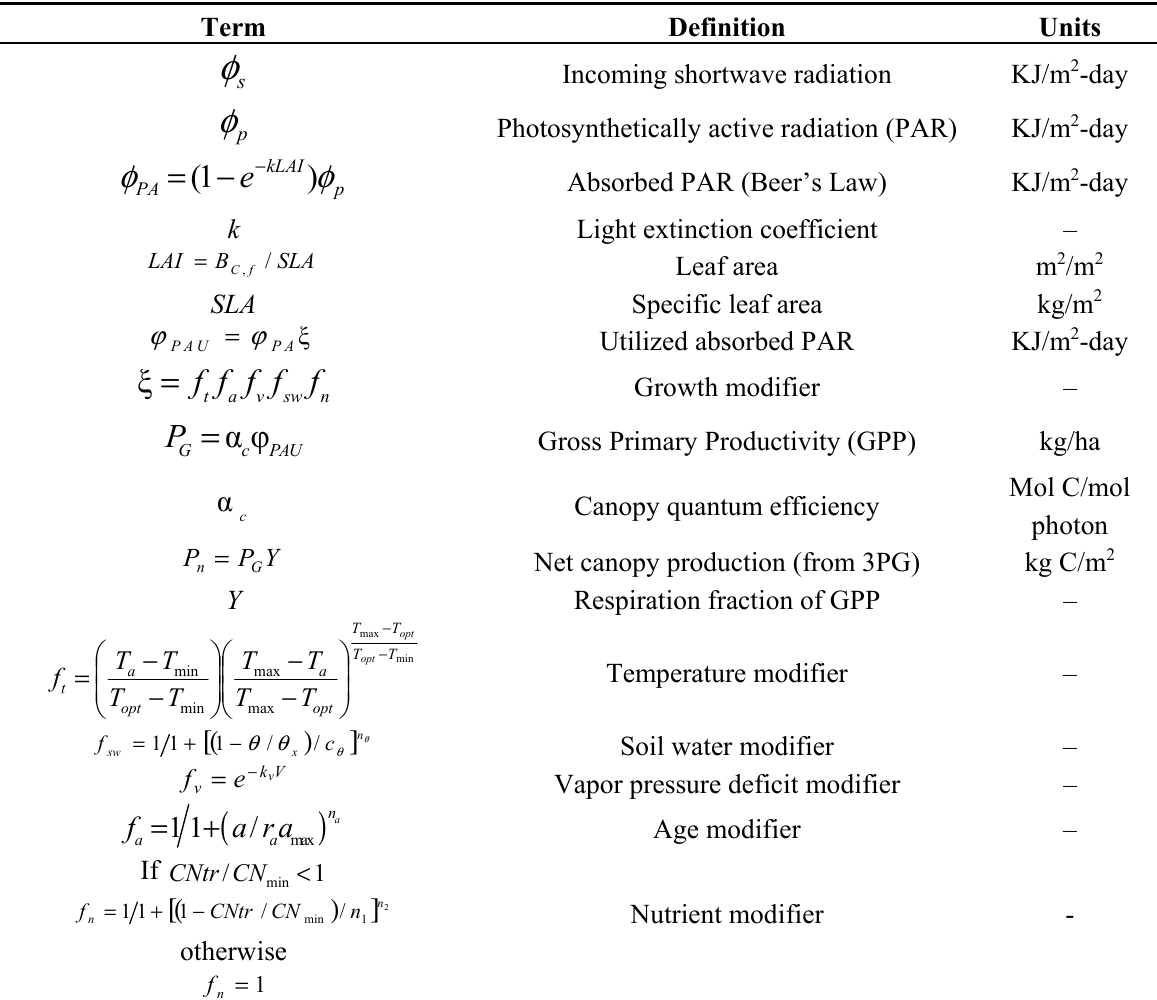
Table 7. Parameters and auxiliary equations completing the production and allocation portions of the